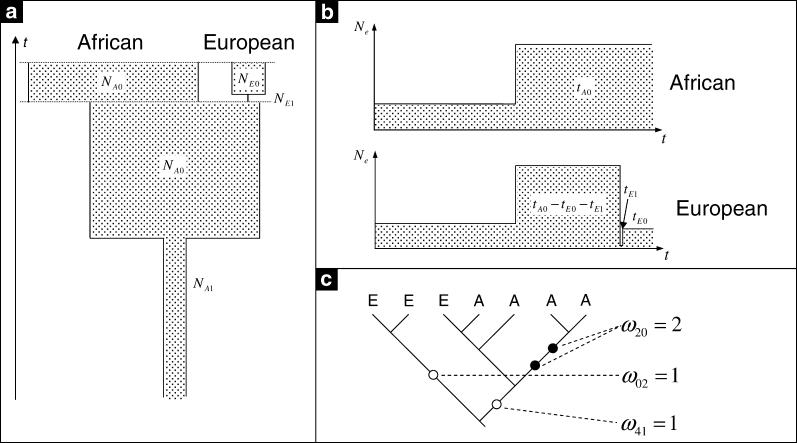
Demographic Models of the African and European Populations(A) The demographic histories are plotted together.(B) The demographic histories are plotted for both populations separately.(C) The joint MFS for an example genealogy where the sample size of European lines (indicated by E) is 3, and that of African lines (A) is 4. ωij is the number of mutations carried by i chromosomes of the African sample and by j chromosomes of the European sample.